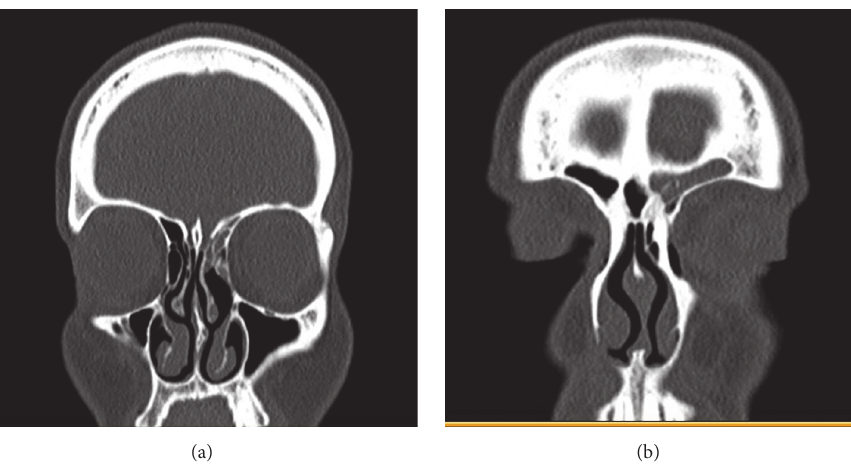
Figure 1: Preoperative coronal CT scan demonstrating evidence of soft tissue density consistent with known inverting papilloma in ethmoid (a) and frontal (b)